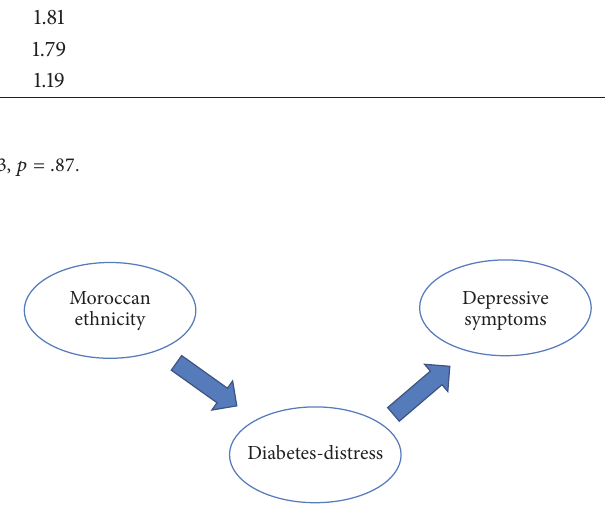
mediated the association between Moroccan origin and EK10 depression ( 𝑝 < .01 ), suggesting an important role for diabetes-distress in this ethnic group (Figure 1). No association was found between other ethnic backgrounds and EK10